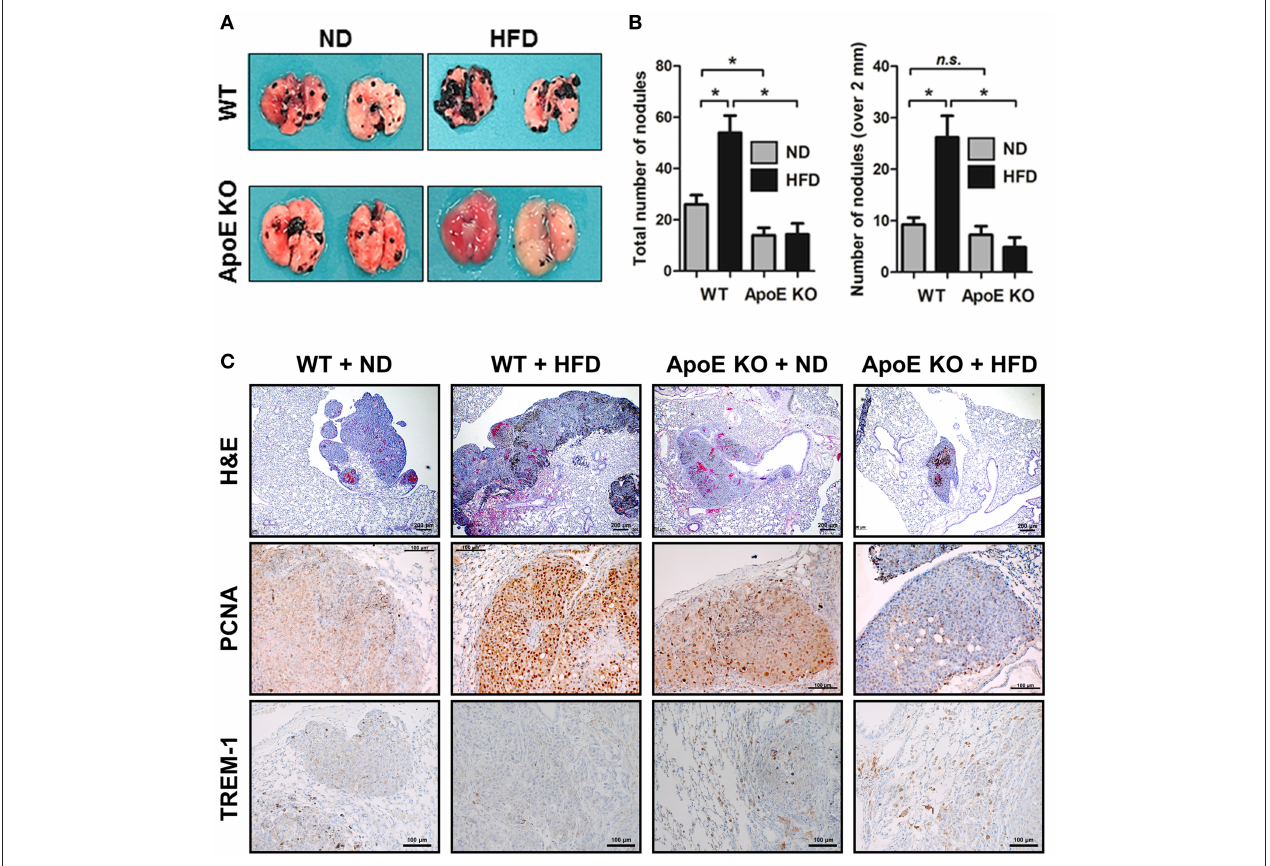
FIGURE 2 | Effect of ApoE knockout on B16F10 lung metastasis. (A,B) B16F10 cells were intravenously injected at mouse tail vein (4 × 10 4 cells/mouse) ( n = 6). After 21 days, mice were sacrificed, and lung metastatic nodules were visualized and counted. (C) Lung metastasis tissues were stained with haematoxylin and eosin or analyzed by immunohistochemistry for detection of positive cells for PCNA and TREM-1. Scale bar, 100 µ m. * p <